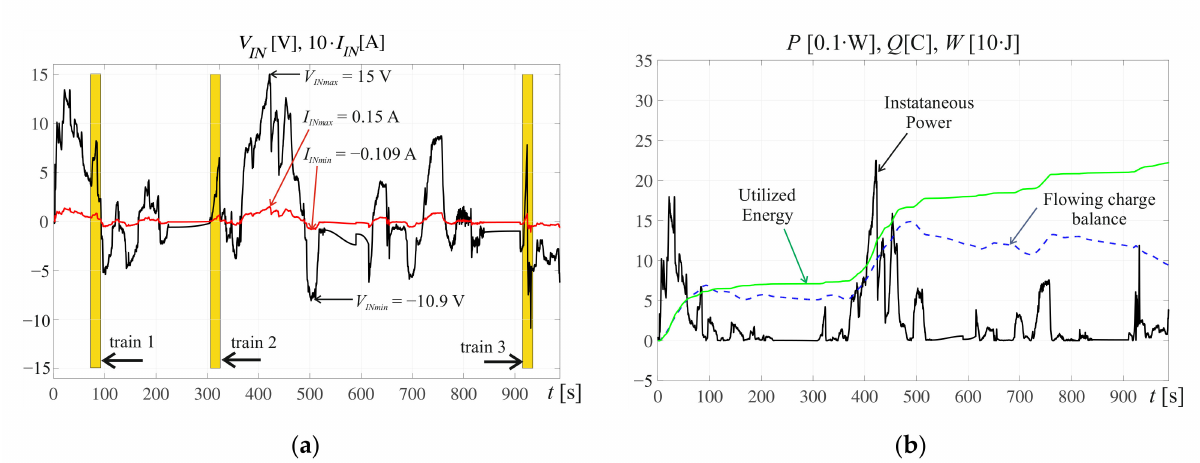
Figure 5. Three trains moving in both directions, 988 s of measurements for the matched input resistance R IN = 100 Ω : P max = 2.25 [W], P av = 225 [mW] and W = 222 [J]: ( a ) Voltage (black) and current (red) on the input of the converter; ( b ) The instantaneous power (black), the utilised energy (green) and the flowing charge balance (dashed).